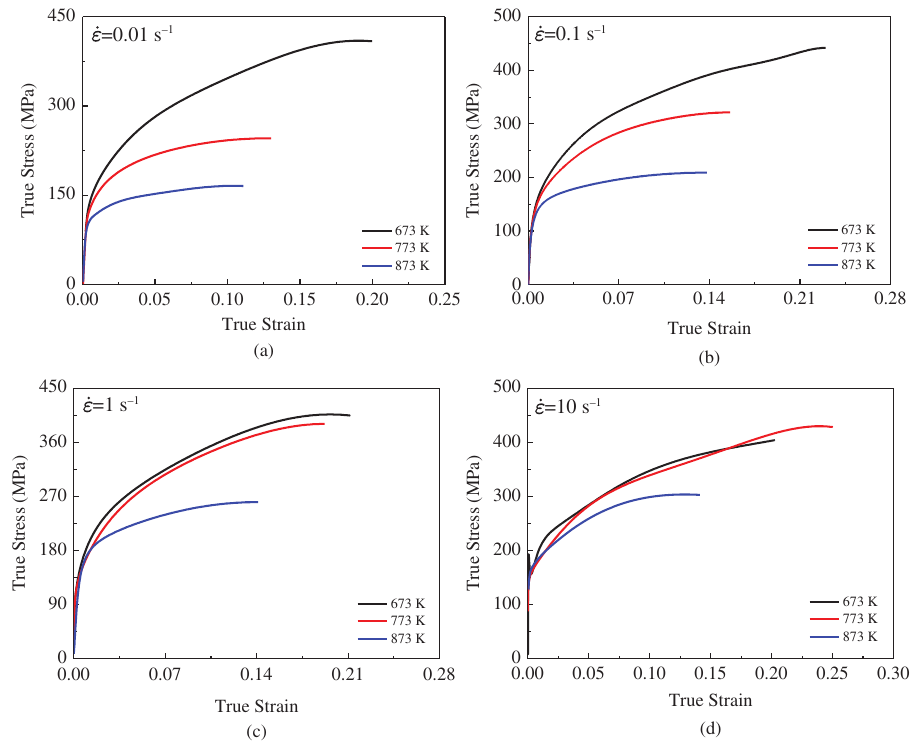
Figure 3: The stress-strain curves of BR1500HS under with the strain rates of (a) 0.01 s − 1 , (b) 0.1 s − 1 , (c) 1 s − 1 and (d) 10 s − 1